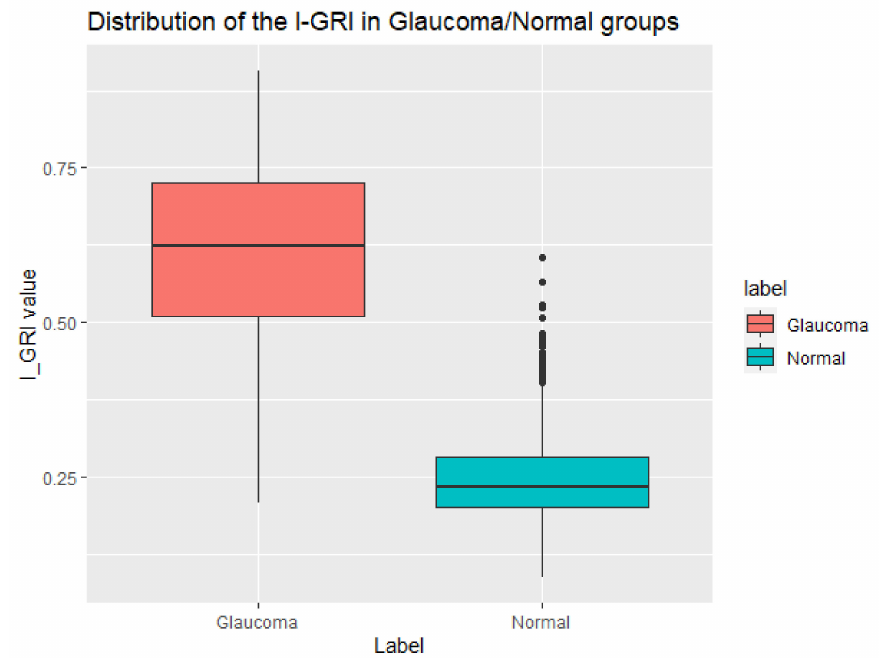
Figure 5. Boxplot of the I-GRI values for the reference dataset. Table 10 and Figure 6 show typical examination data and I-GRI values for the glaucoma, border section, and normal groups. In the radar chart in Figure 6, the gray polygon line indicates the threshold of each feature for classifying glaucoma and normal cases. If an